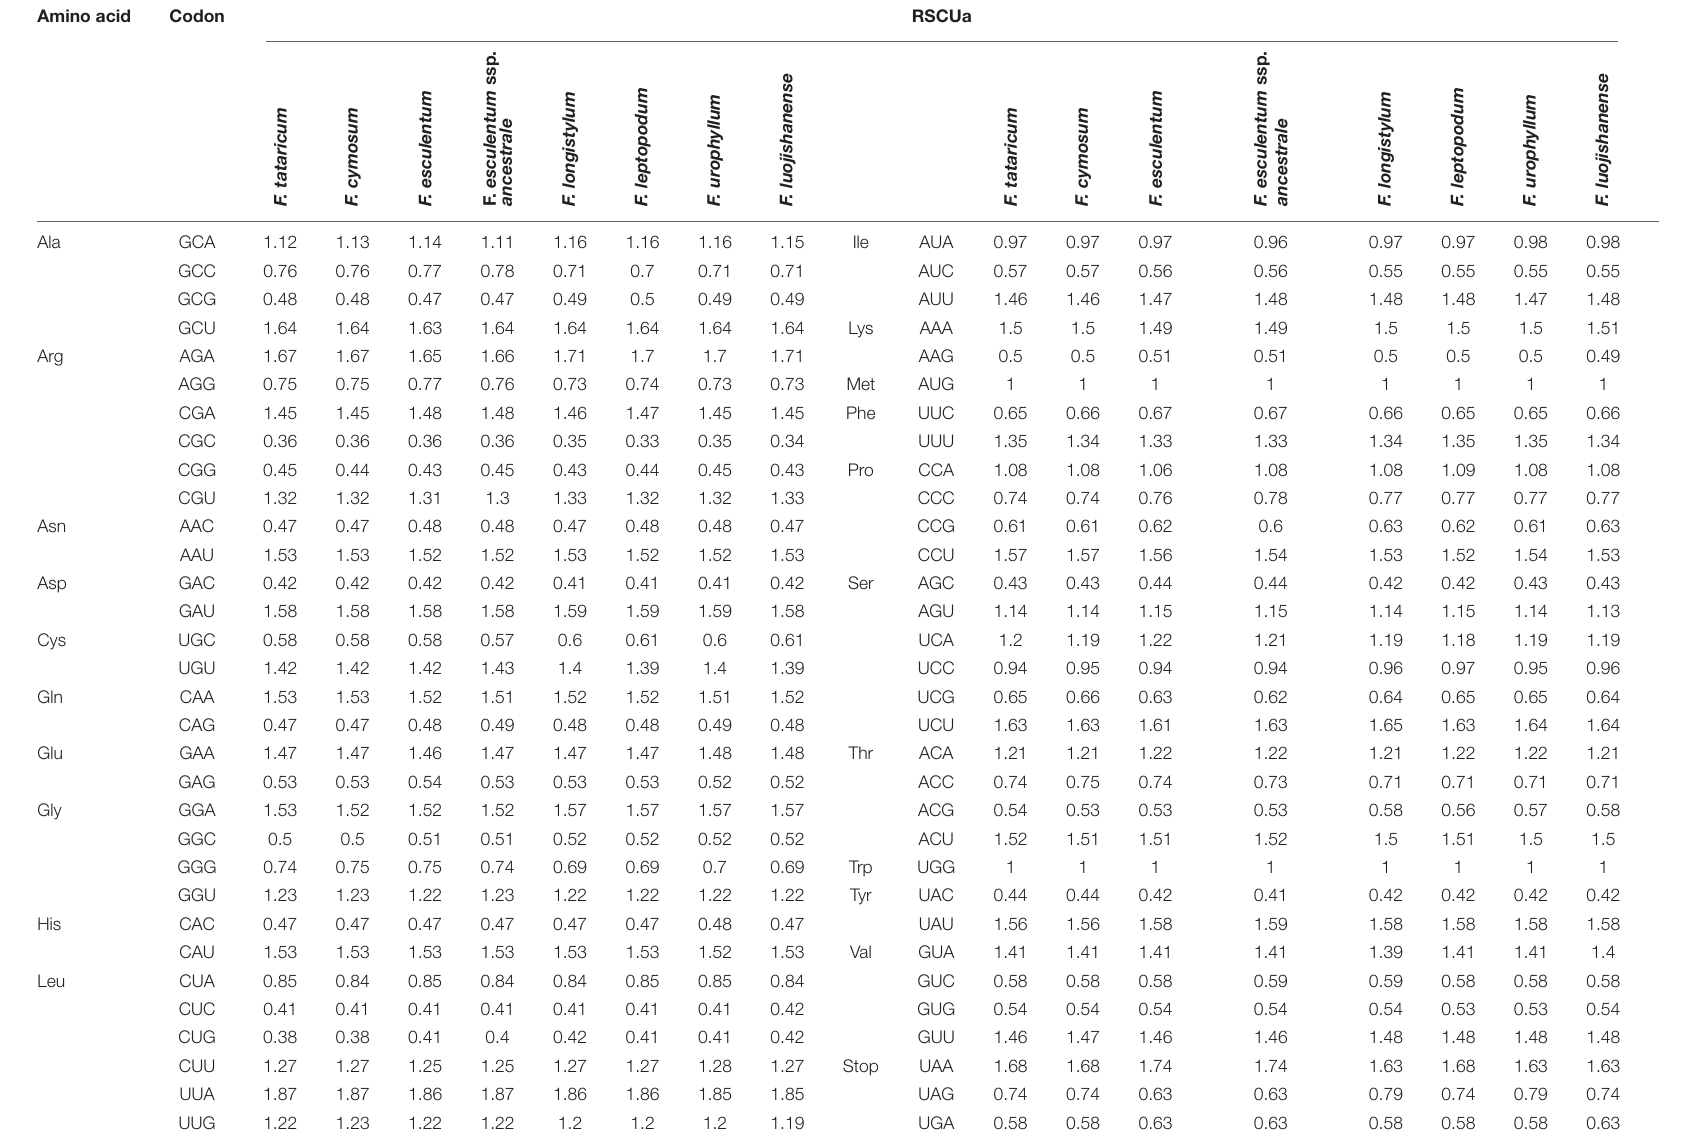
TABLE 3 | Codon content of amino acids and stop codon of eight Fagopyrum